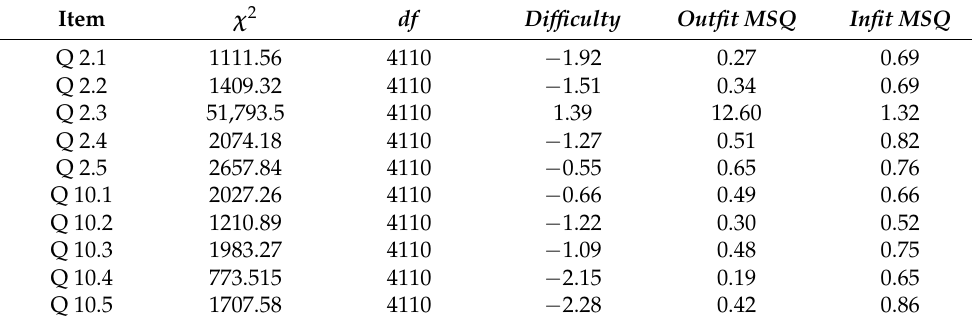
Table 8. Item-level estimates and fit statistics for the Rasch